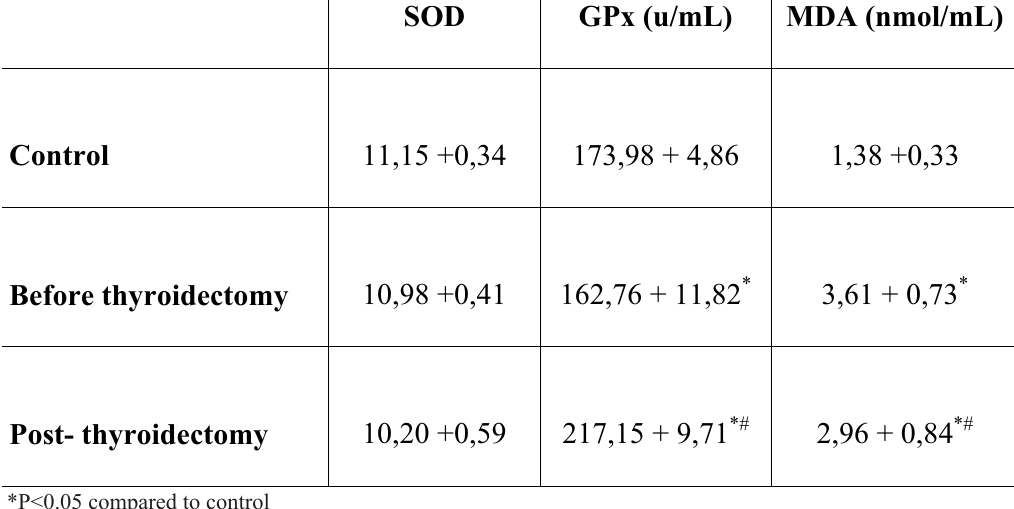
TABLE 2 - Antioxidants enzyme activities and MDA levels in thyroid